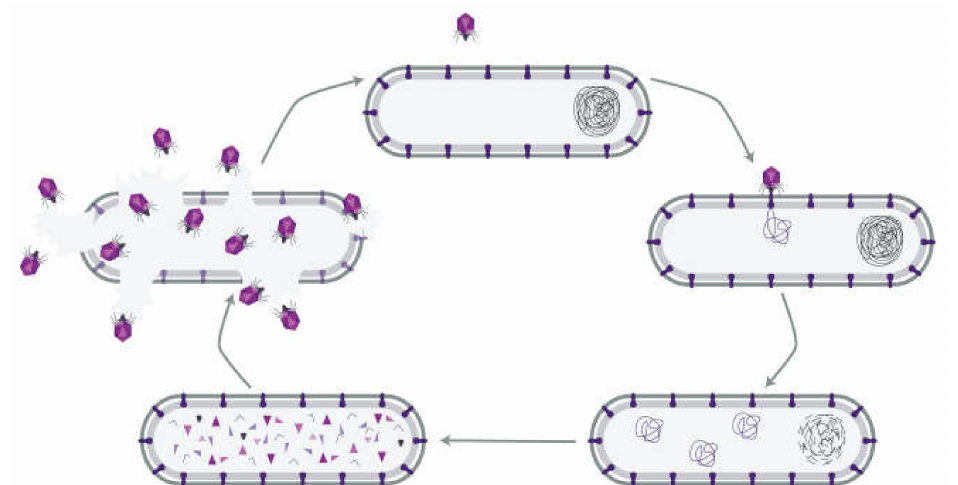
Figure 1. The lytic infection cycle of a bacteriophage. A phage particle attaches to a receptor on the surface of a host bacterium and delivers its genome into the cytoplasm. Phage proteins and replicate genomes are synthesized and self- assemble into new phage particles that eventually lyse the bacterium. The phages then infect other bacteria with the particular receptor (reproduced with permission from Kortright et al., 2019